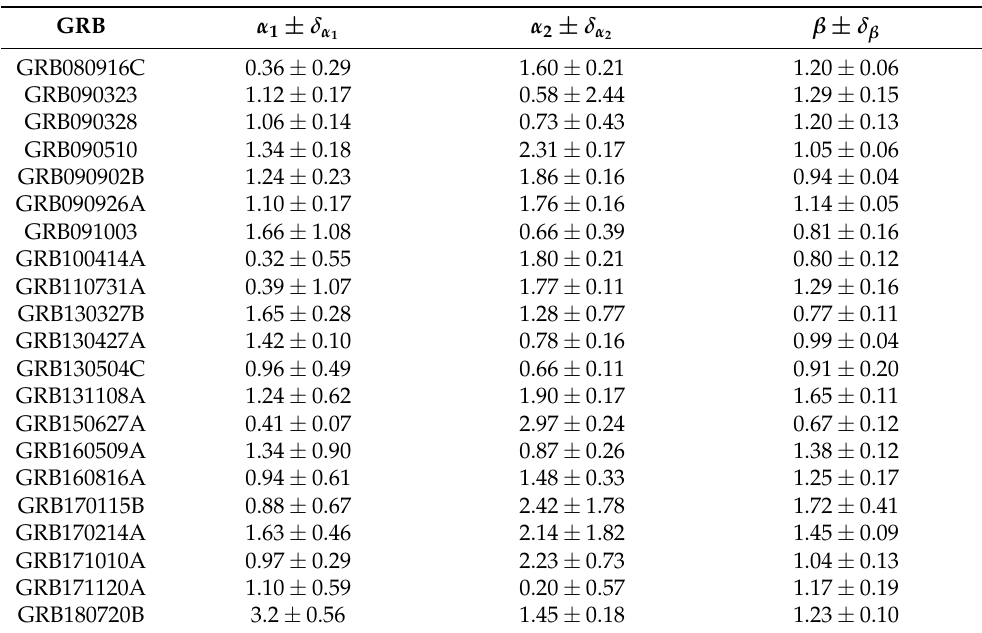
Table 2. Sample of 21 GRBs used in this analysis, fit with a broken power law. Temporal and spectral indices are taken from Ajello et al.